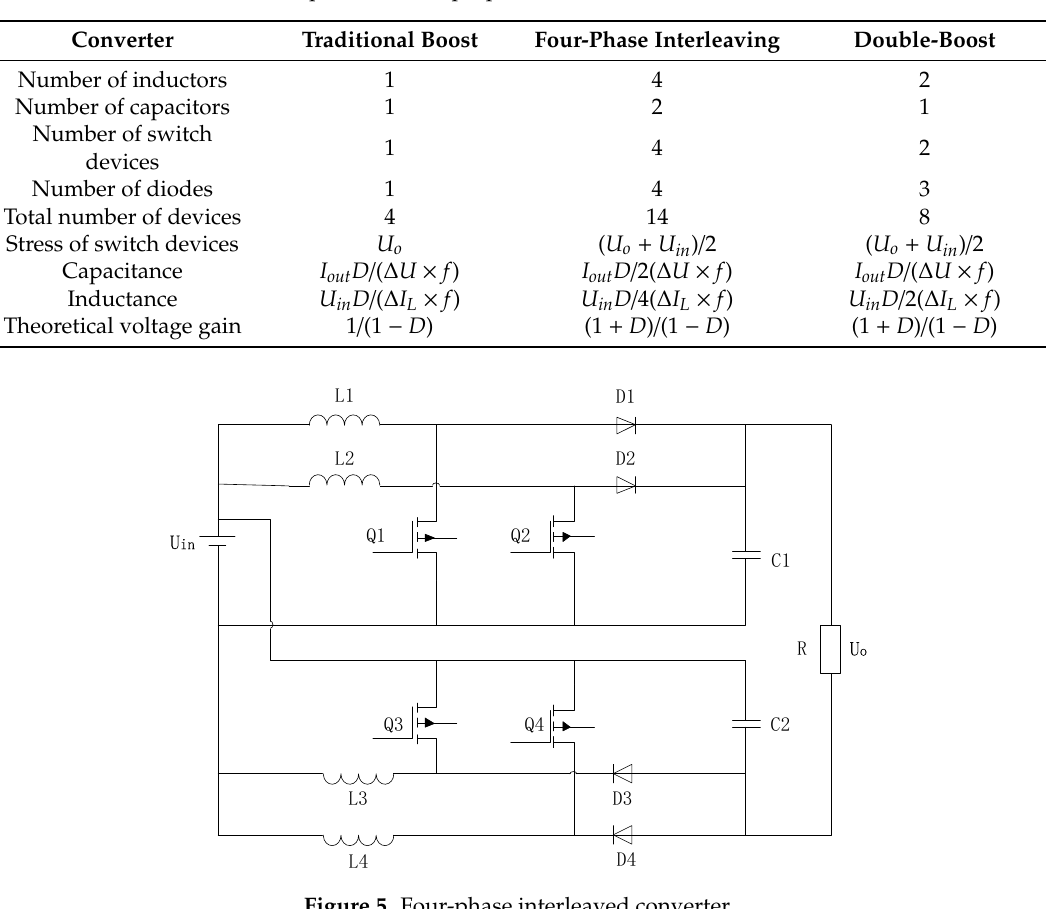
Table 2. Comparison of the proposed converter and other converters.